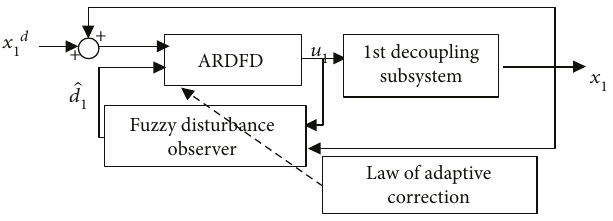
Figure 3: The closed-loop model of the 1st decoupled